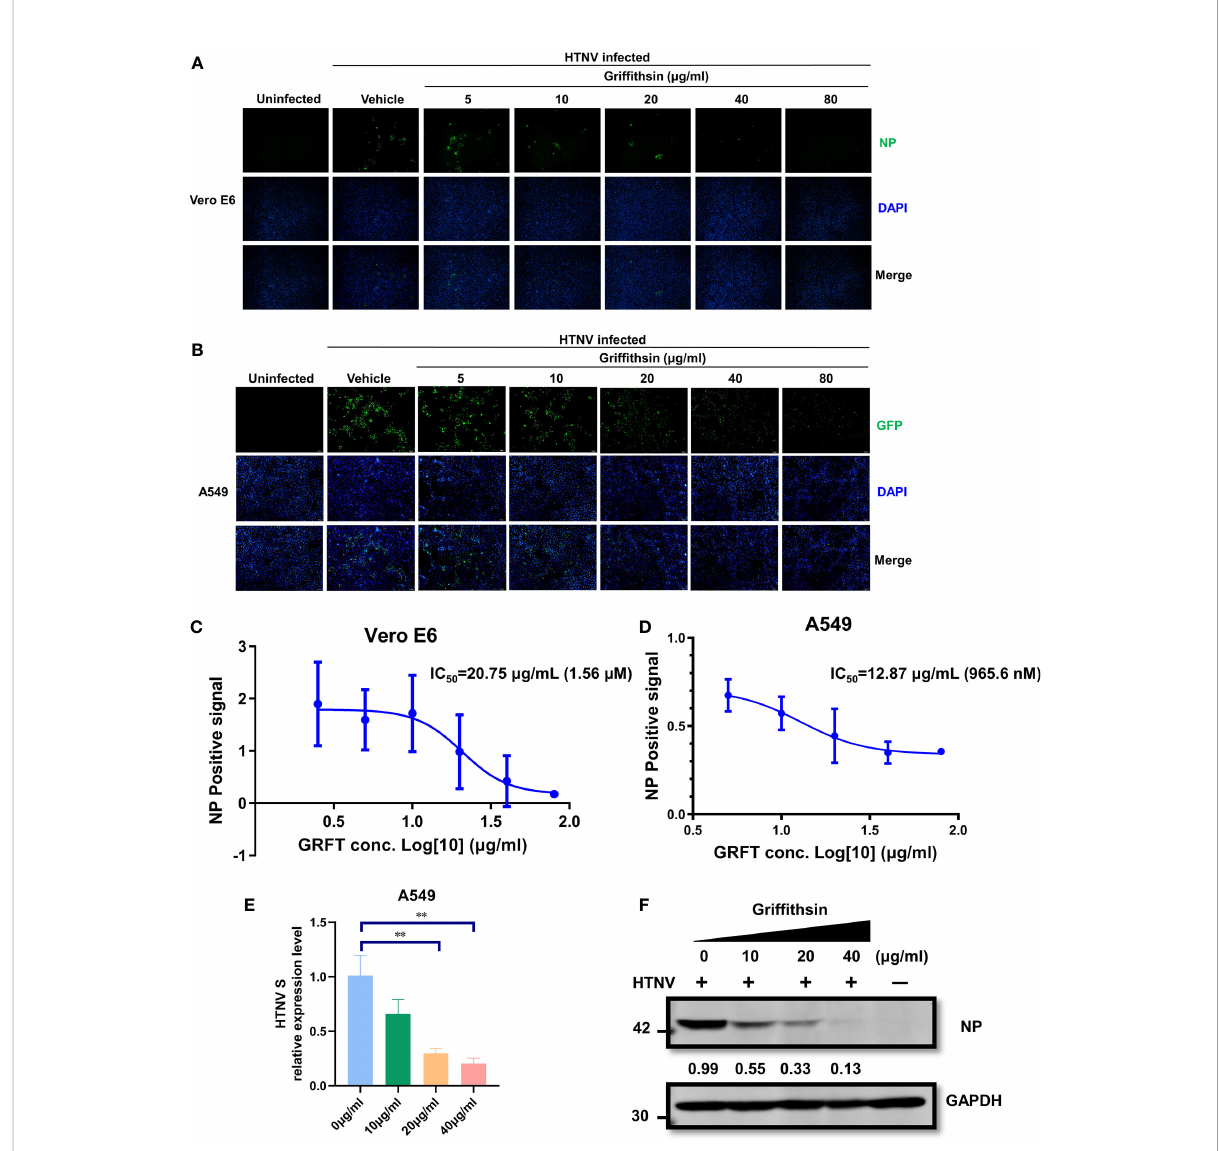
FIGURE 3 GRFT inhibits HTNV replication. (A, B) HTNV was treated with varying concentrations of GRFT for 1 h. The mixture was then used to infect Vero-E6 (A) or A549 (B) cells at an MOI of 1. At 72 h post-infection, the cells were fi xed, permeabilized, and stained with a mouse monoclonal antibody 1A8 against HTNV nucleoprotein. Green, HTNV nucleoprotein; blue, cell nuclei. (C, D) The dose – response curve shows the quantitation of HTNV nucleoprotein-positive Vero-E6 (C) or A549 (D) cells after HTNV treatment with GRFT (% normalized to the vehicle-only control). (E) The HTNV S segment RNA level in A549 was detected and normalized to GAPDH. (F) The HTNV nucleoprotein in A549 cells was detected with an NP-speci fi c antibody and normalized to the GAPDH level. Data shown in the graphs are presented as the mean ± SD and are representative of